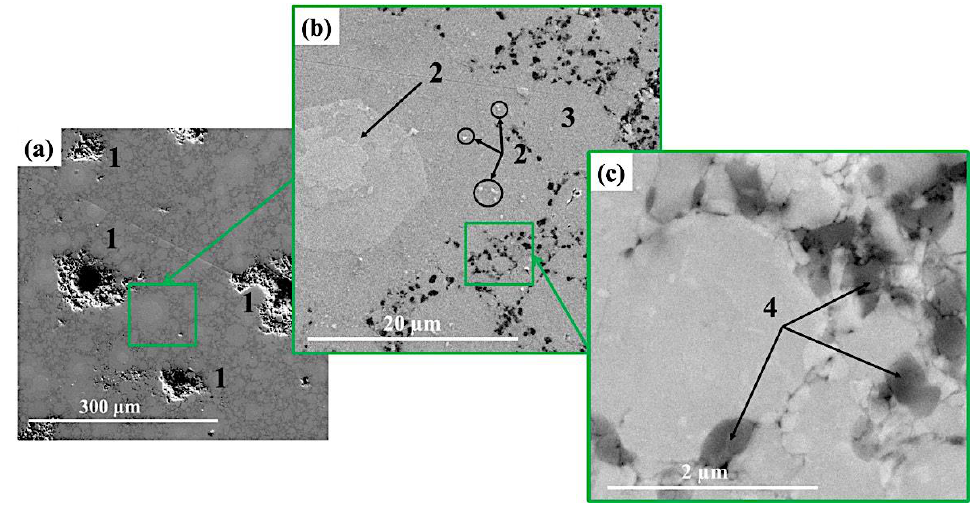
Figure 4. SEM image of materials obtained by MEAM-HP with subsequent sintering at 1100 ± 20 °C: × 550 ( a ), ×8300 ( b ), ×82 800 ( c ).